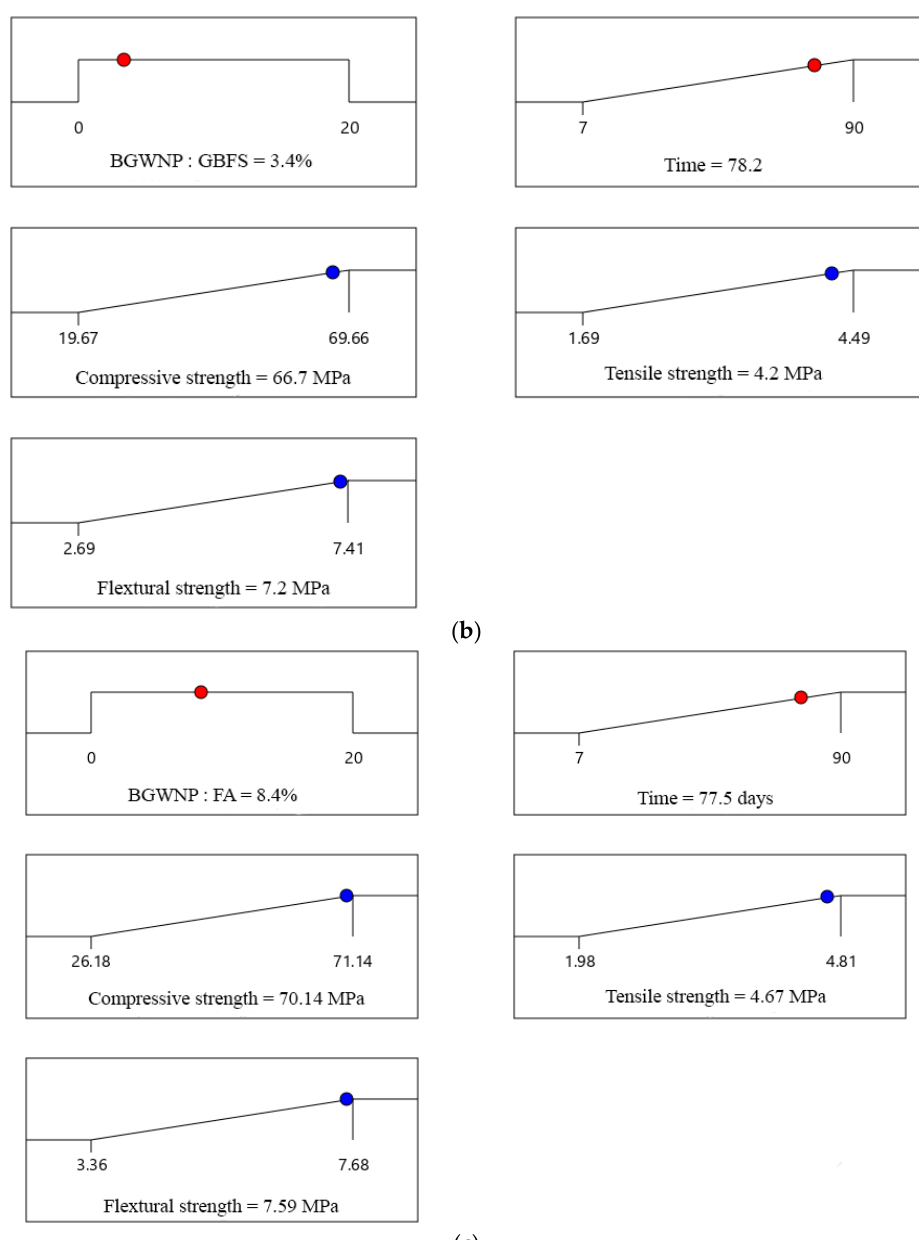
Figure 5. The optimum content of BGWNP ( a ) at constant FA-GBFS ratio (Model 1), ( b ) as the replacement of GBFS (Model 2), and ( c ) as the replacement of FA (Model 3).